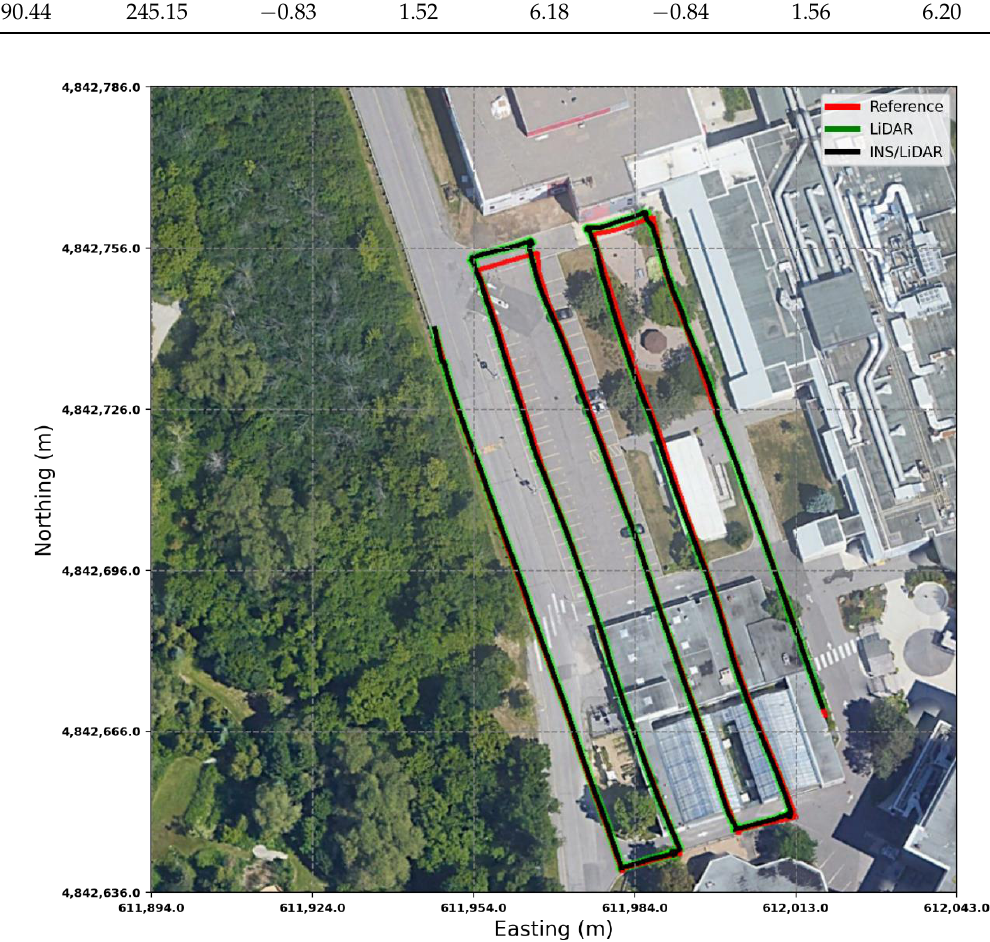
Figure 15. GNSS assisted: comparison of trajectories.